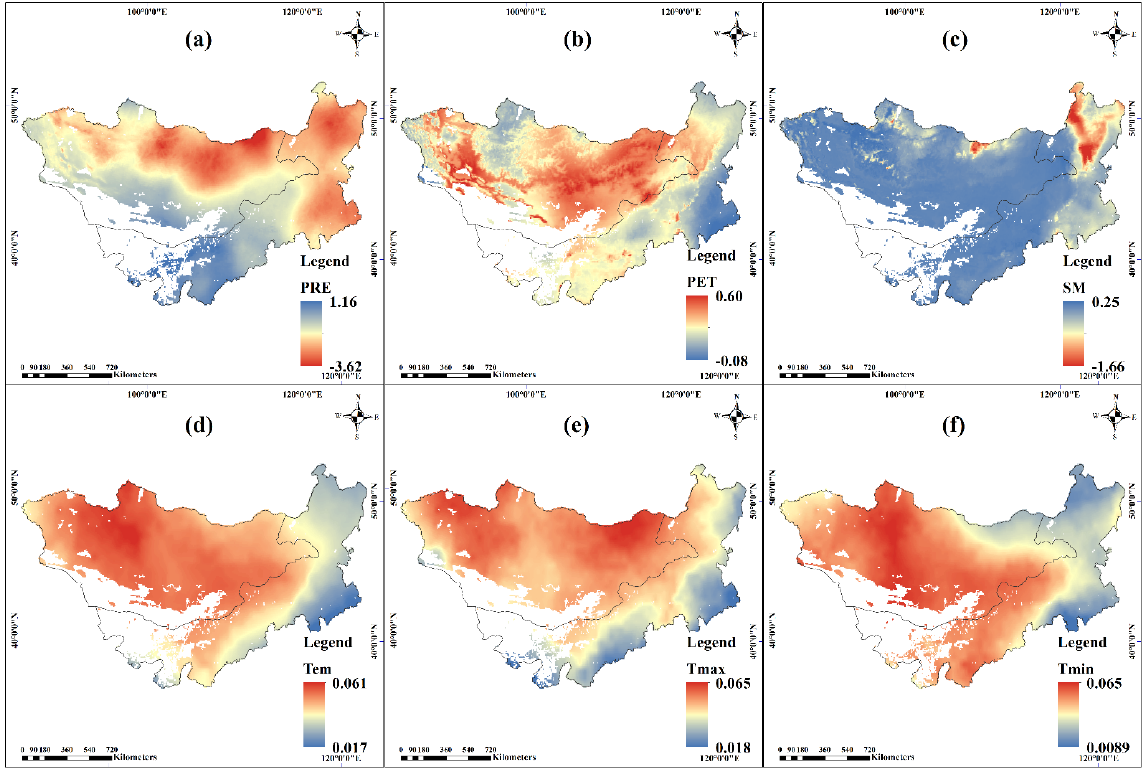
Figure 3. Spatial trends distribution of climatic factors during the growing season of 1982 – 2015 in the Mongolian Plateau. ( a ) PRE, ( b ) PET, ( c ) SM, ( d ) Tem, ( e ) Tmax, ( f ) Tmin .